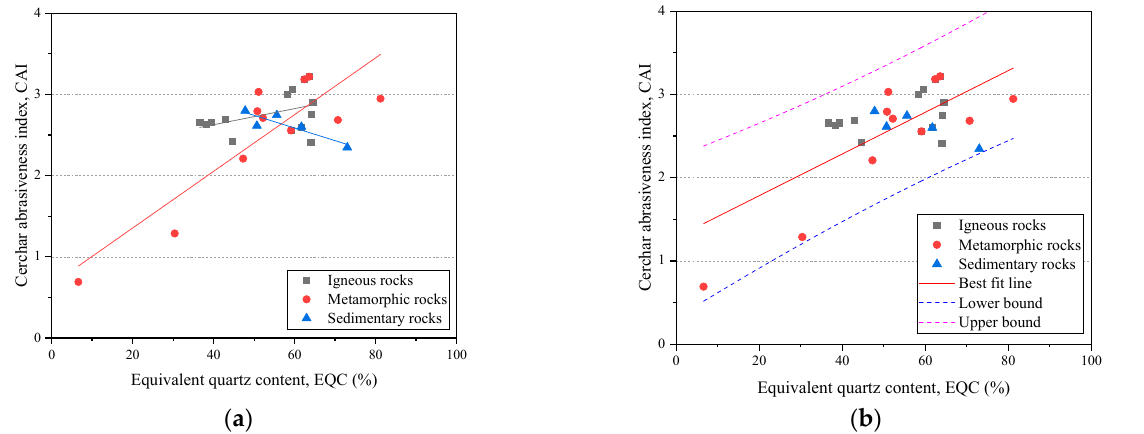
Figure 12. The relationships between the Cerchar abrasiveness index and equivalent quart content: fitting for ( a ) each rock origin, and ( b ) all rock types. Table 7. Prediction models for the Cerchar abrasiveness index.